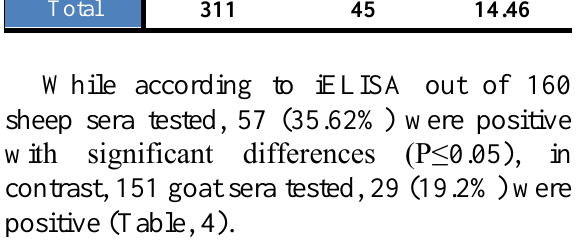
Table, 4: Positivity of sheep and goat brucellosis